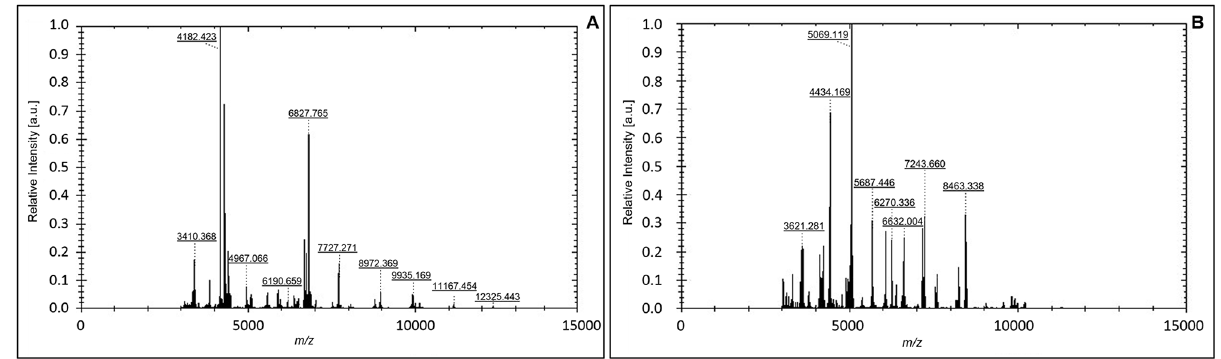
Fig 5. Main spectraof the species Exiguobacterium oxidotolerans (a) and Pseudomonas costantinii (b) obtained by MALDI-TOF analysis. The relative intensity of the ions (arbitrary units, a.u.) and their mass to charge ratio ( m/z ) are shown on the y and x-axis ,